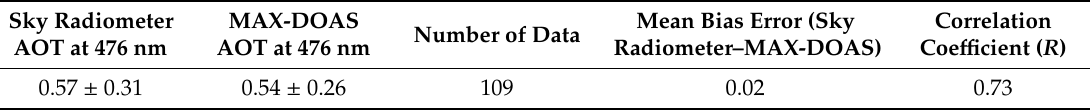
Figure 3. (top panel) ( a ) Sky radiometer and MAX-DOAS AOT at 476 nm retrieved form the observations in Phimai, ( b ) The absolute differences between MAX-DOAS and sky radiometer AOT at 476 nm in Phimai. ( c ) The absolute differences between MAX-DOAS and sky radiometer AOT at 476 nm on April 23, 24, and 25 and August 21 and 22. (bottom panel) Coincident LIDAR observations at the Phimai site on ( d ) April 23, 24, and 25 and ( e ) August 21 and 22. The LIDAR images were obtained from the NIES LIDAR website (https://www-lidar.nies.go.jp/Phimai/archives/, last access 2020/7/15). Table 7. Summary statistics for the sky radiometer and MAX-DOAS observations in Phimai. All the coincident data for the observation period were used to calculate the mean